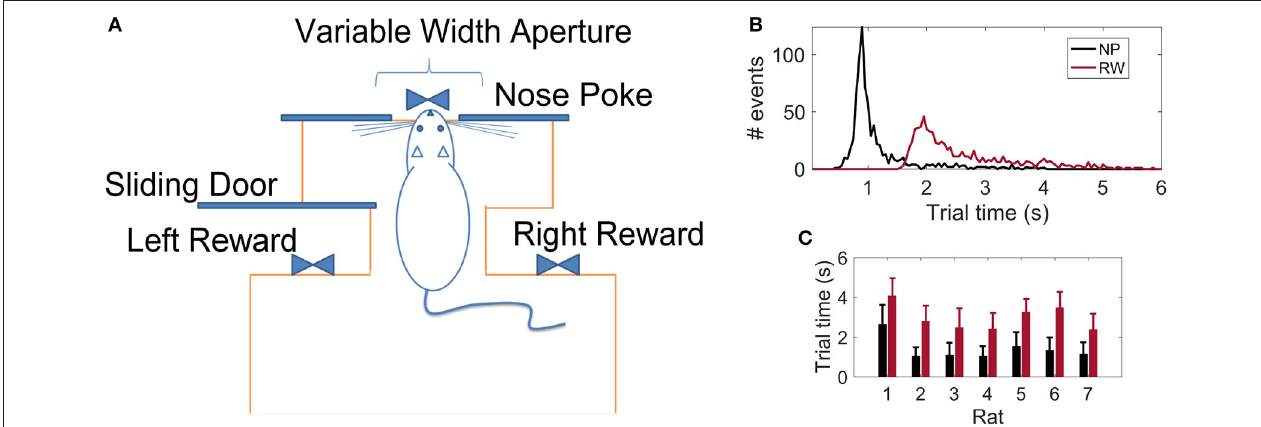
FIGURE 1 | (A) Schematics of the behavioral apparatus: the animal has to discriminate between a wide or narrow aperture employing only their mystacial vibrissae in order to get a water reward (adapted from Krupa et al., 2001). (B) Distribution of reaction times considering 764 trials from all 7 rats: time to reach the Nose Poke (NP) or Reward (RW) sites with respect to the Central Door event ( t 0 s). (C) Reaction times per animal (mean = ±